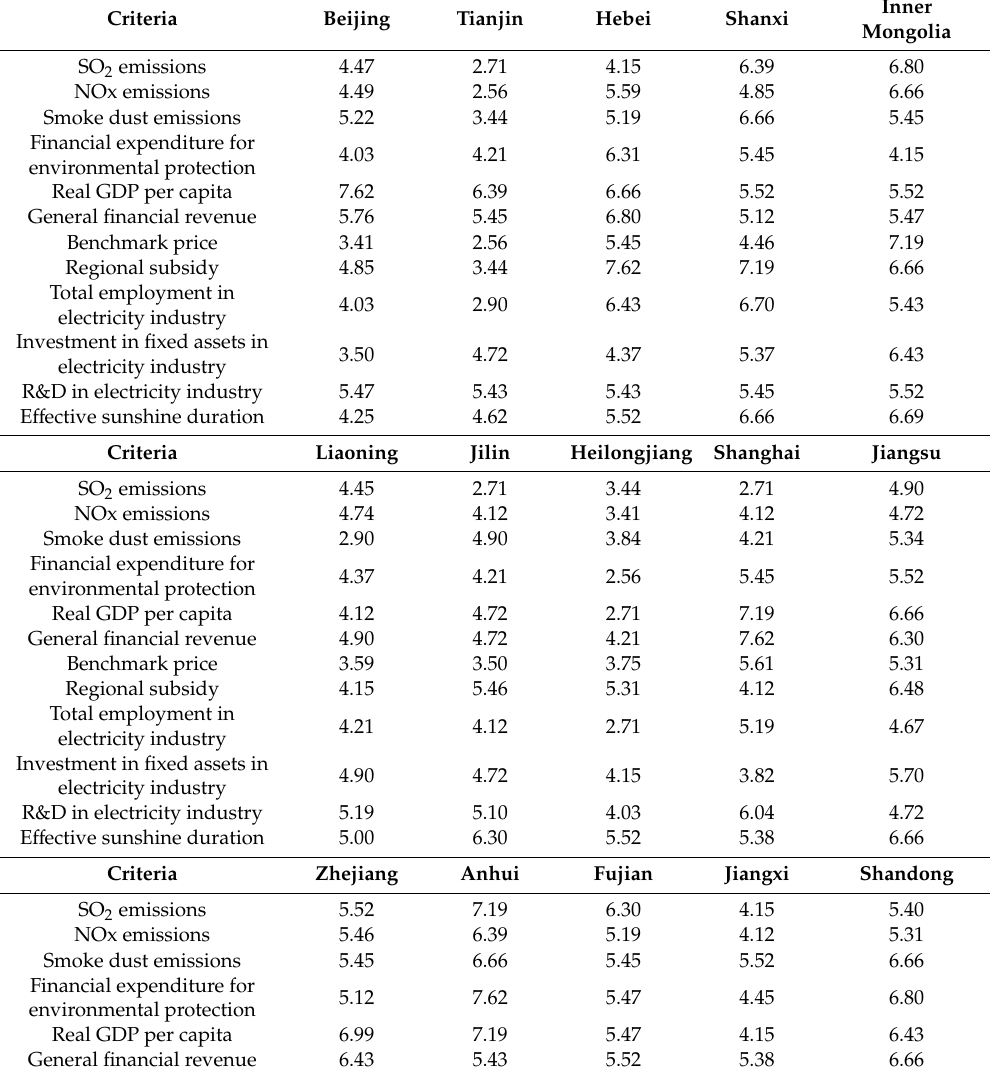
Table A6. The BNP values of 30 regions on 12